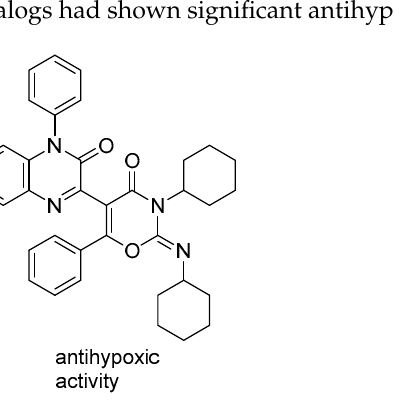
Figure 2. Close analog of quinoxaline derivative 1